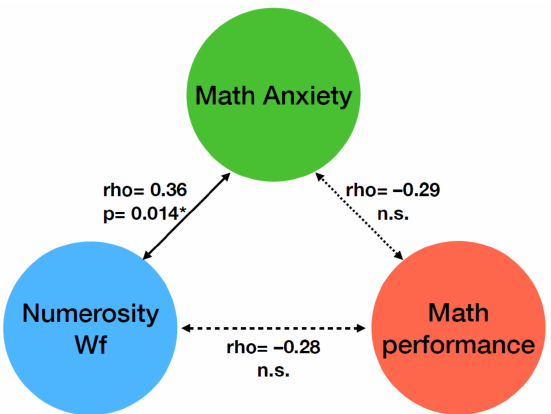
Figure 3. Diagrams of partial correlations between math anxiety, numerosity Wf and formal math performance. Values report partial correlations between the two variables connected by arrows after controlling for the third variable. * p <